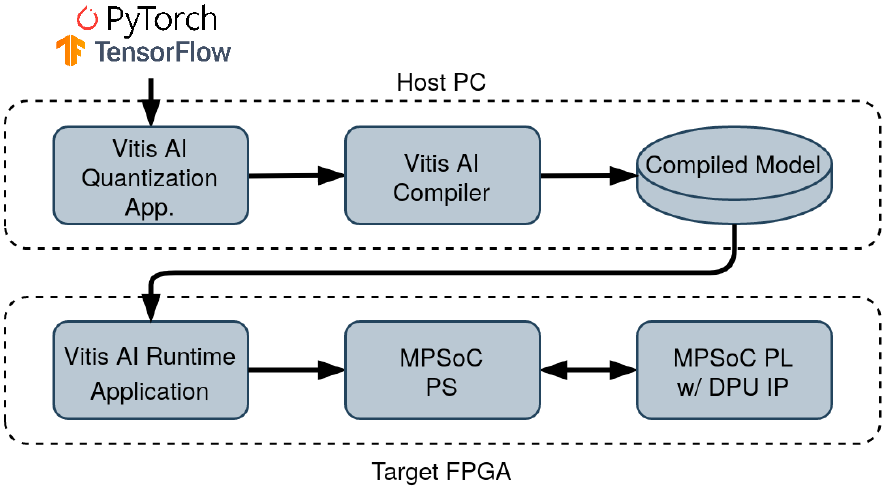
Figure 8. The Vitis AI development flow that we followed in the current